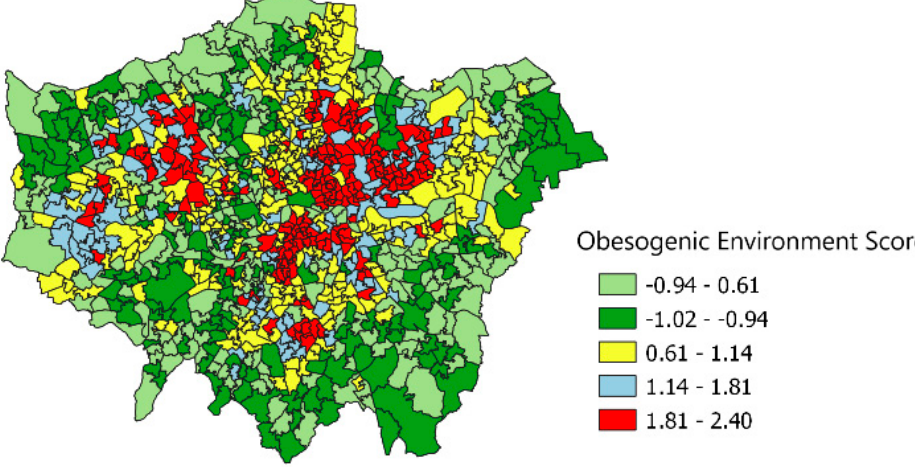
Figure 2. Greater London. Obesogenic Environment Index. Second Measurement